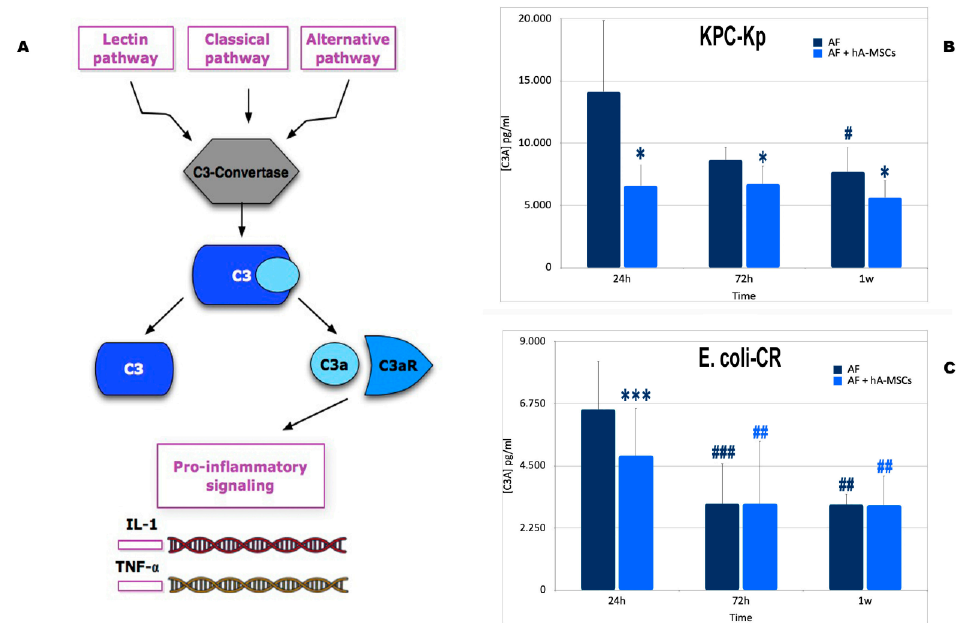
Figure 6. ( A ) The figure shows a very simplified view of the complement system. The complement system can be initiated by three different pathways: the classic pathway, the lectin pathway, and the alternative pathway, all converging on the formation of C3 convertases. This classic C3 convertase activates and cleaves C3 molecules into C3b and C3a. C3a is a critical chemotactic mediator that exerts various effects after binding to the C3a receptor (C3aR). C3a/C3aR plays pro-inflammatory effects, upregulating the expression of proinflammatory mediators releasing extracellular ATP in monocytes or macrophages and promoting T cell proliferation. ( B ) C3A production during AF’ infection with KPC-Kp cultured with or without hA-MSCs for 24 h, 72 h, and 1 week. Significant decrease was shown only during culture with hA-MSCs after 24 h, 72 h and 1 week ( p < 0.05, *) compared to Control 2. WBCs cultured without hA-MSCs (Control 2) showed a significantly decrease at 1 week compared to 24 h ( p < 0.05, #). ( C ) C3A production during AF infection with E. coli-CR cultured with and without hA-MSCs for 24 h, 72 h, and 1 week. A significant decrease of AF plus hA-MSCs was shown only at 24 h ( p < 0.001, ***) compared to Control 2 at the same time. While, both at 72 h and at 1 week, there were no significant changes in C3a production in the presence or absence of hA-MSCs at the same analyzed time points. The data obtained showed a significant decrease in C3A at 72 h and at 1 week in both samples analyzed compared to 24 h (Control 2 at 72 h, p < 0.001, ###; at 1 week, p < 0.01, ##; WBCsAF plus hA-MSCs, at both 72 h and 1 week ( p < 0.01,